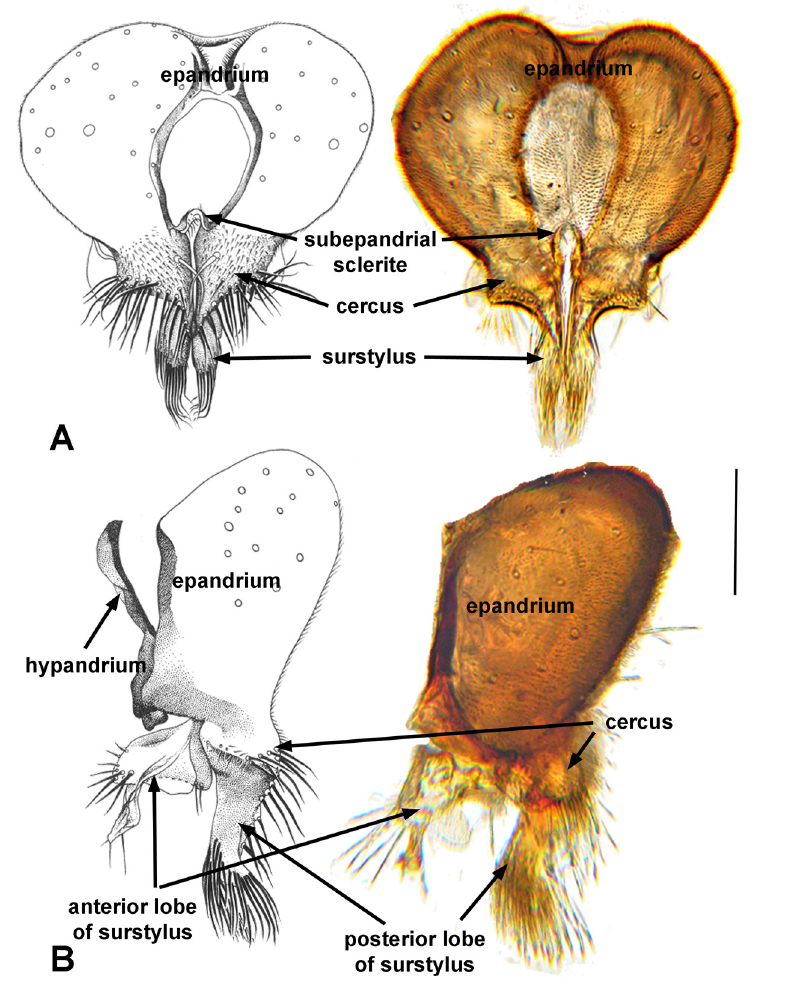
Fig. 2 . Rudolfina tumida sp. nov. A . Male epandrium, cerci and surstyli, posterior view. B . Male epandrium, cercus and surstylus, lateral view. Illustrations and photographs from debu01086083. Scale bar: A–B =